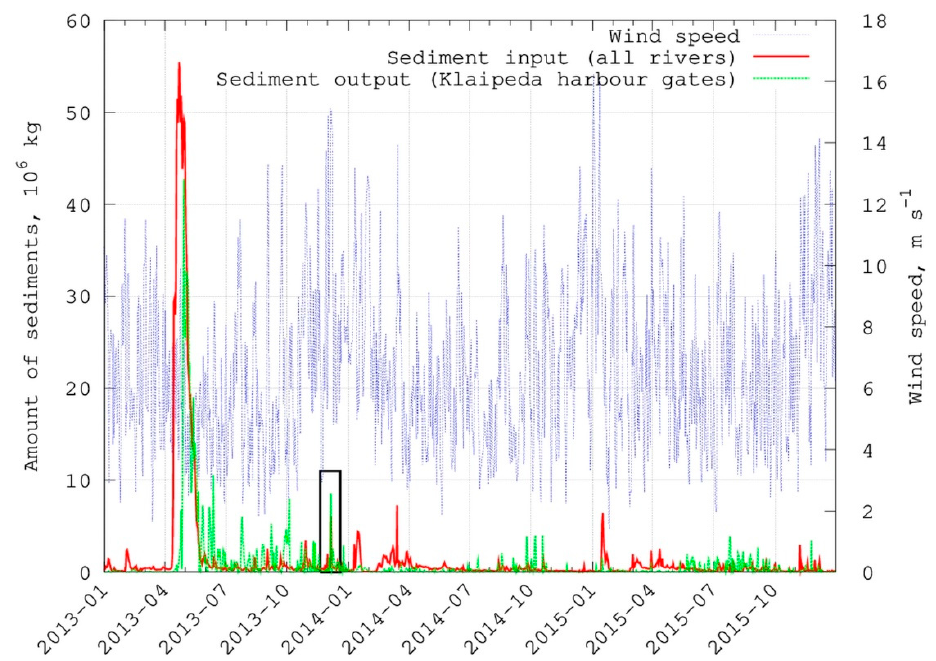
Figure 12. Time series of sediment input and output from the Curonian Lagoon to the sea. Black rectangle indicates the discussed storm event.